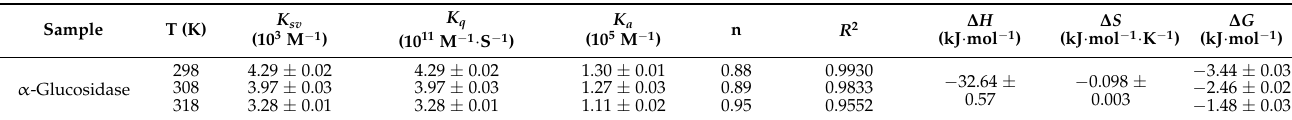
Table 3. The values of quenching and binding parameters for C3G binding with α -glucosidase at different temperatures (298, 308, and 318